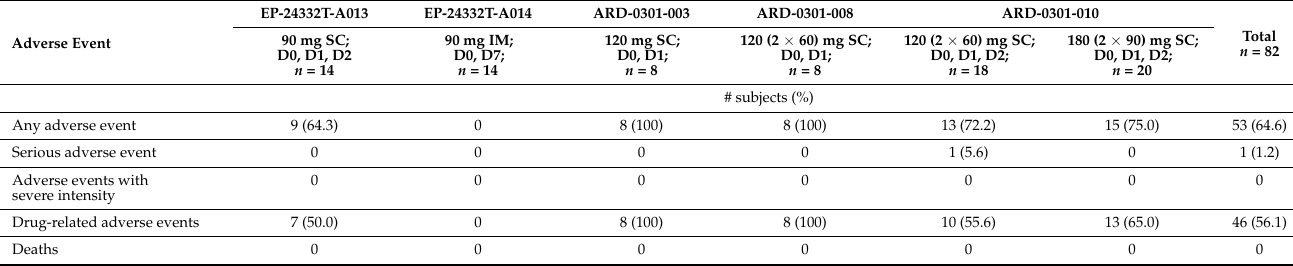
Figure 3. Mean total testosterone (ng/mL), luteinizing hormone (IU/L) and PSA (ng/mL)(+SEM) vs. time (days). IM = intramuscular; LH = luteinizing hormone; PD, pharmacodynamics; PSA = prostate-specific antigen; SC = subcutaneous; T = testosterone. Table 3. Overview of adverse